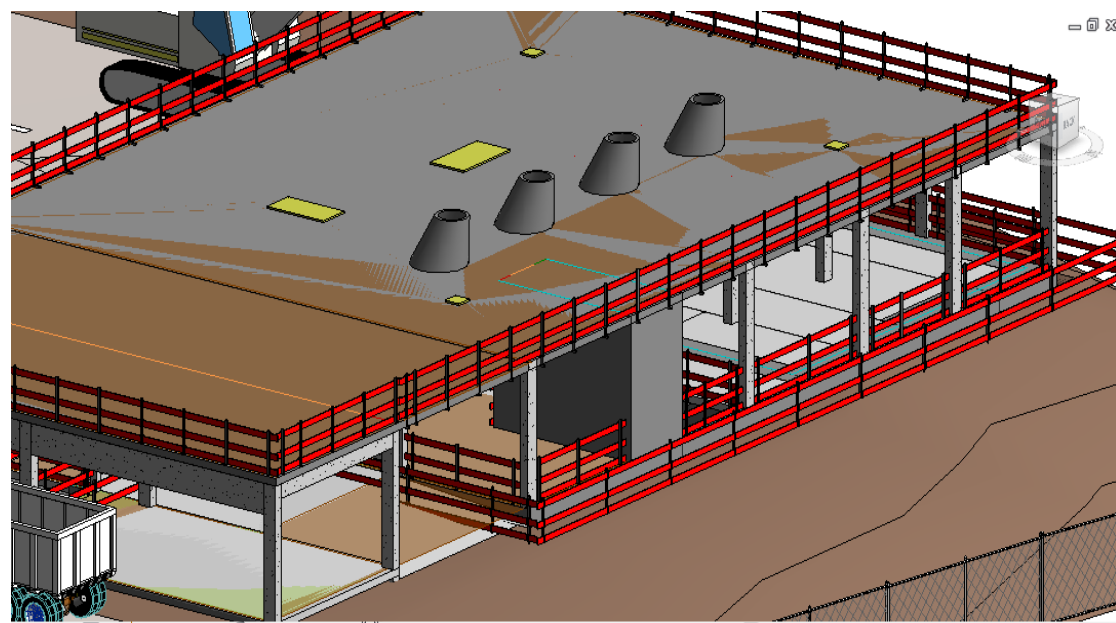
Figure 2. The structural 3D model with safety elements.